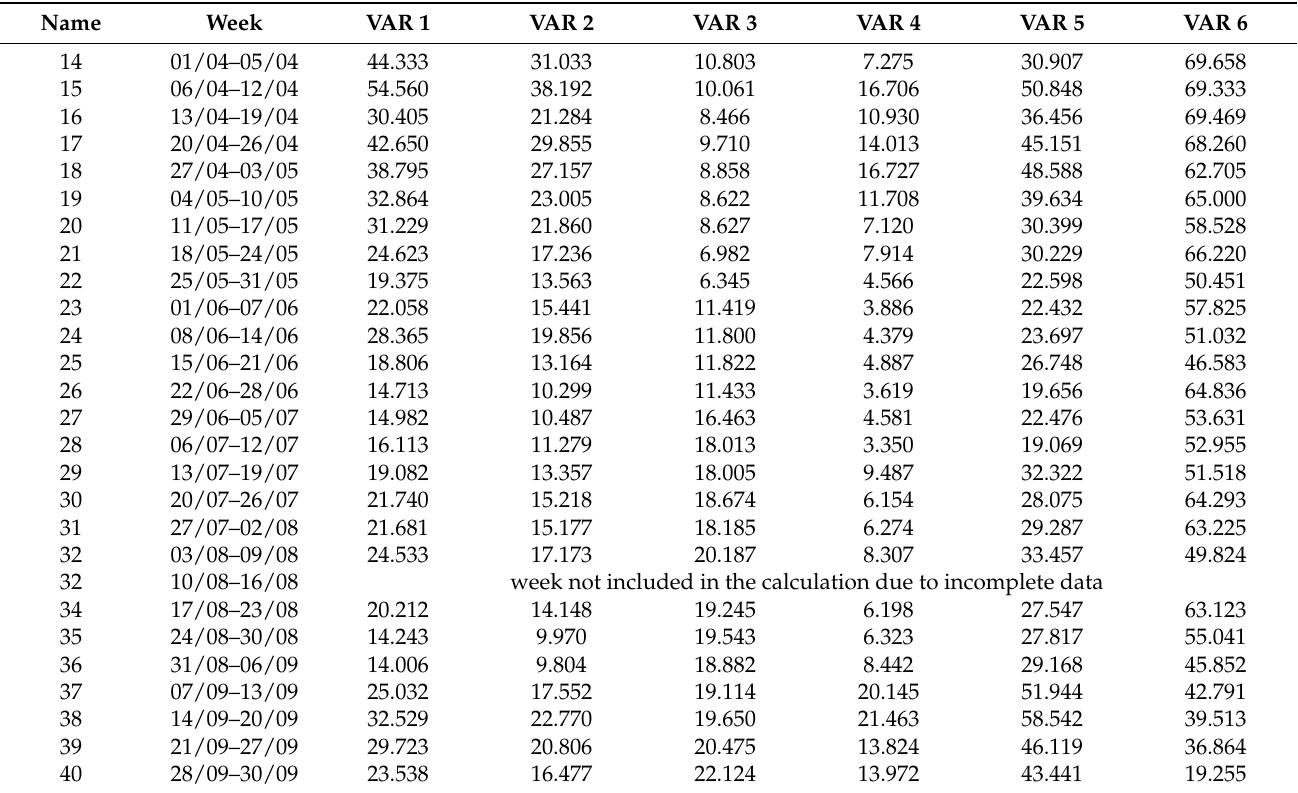
Table 3. Summary (weekly average values) of the concentration of PM 10 ( µ g/m 3 ), PM 2.5 ( µ g/m 3